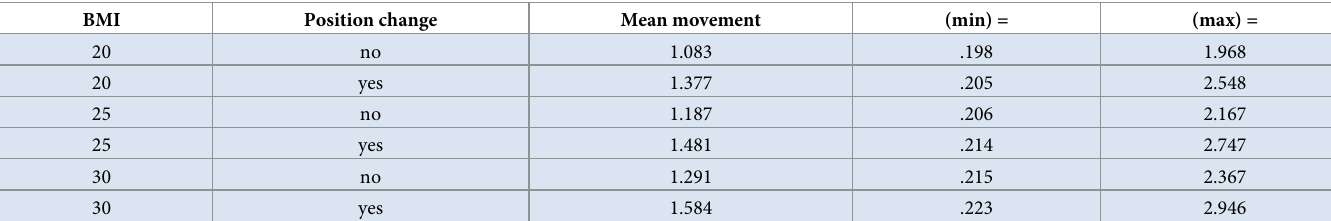
Table 3. Multiparameter regression analysis of CVC tip movement between two consecutive